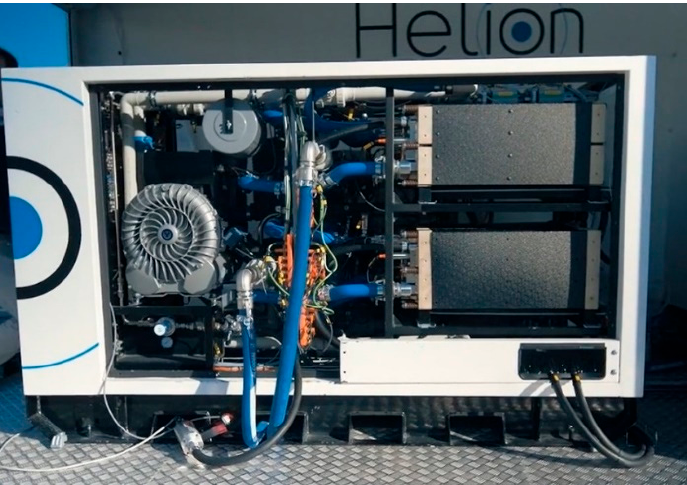
Figure 16. The 200 kW FC-RACK TM Marine PEMFC [93].